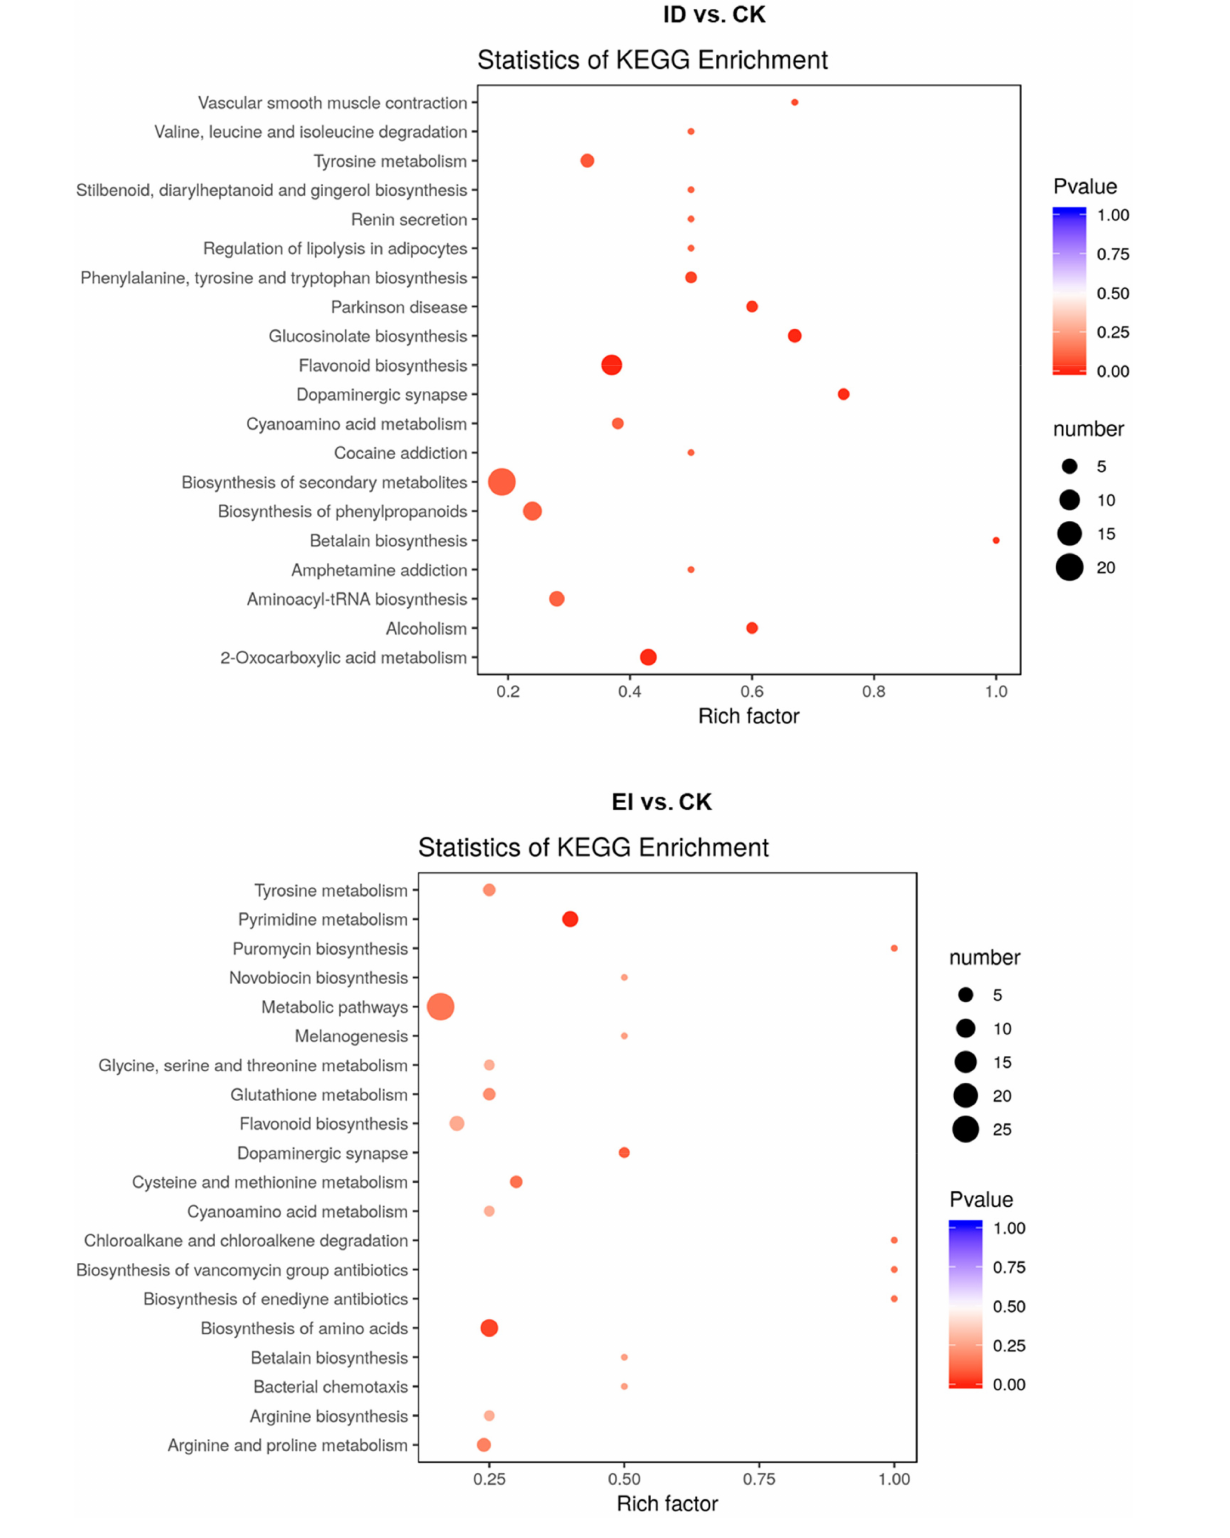
Frontiers in Plant Science |